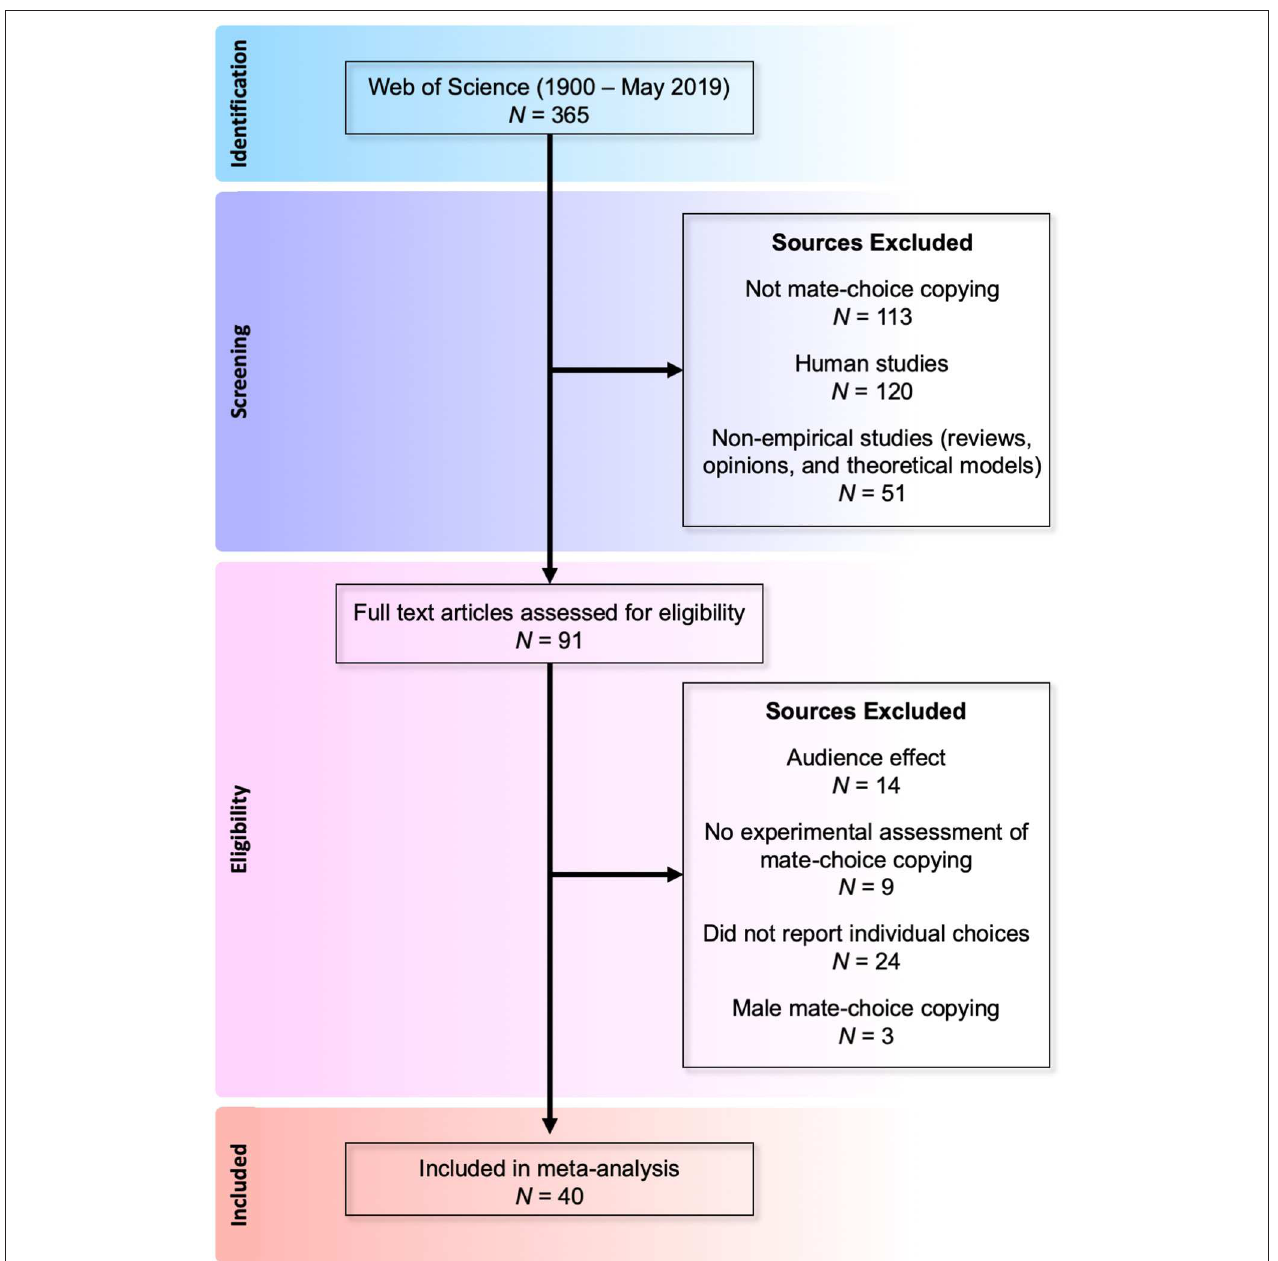
FIGURE 1 | Flow diagram of selection process for female mate-choice